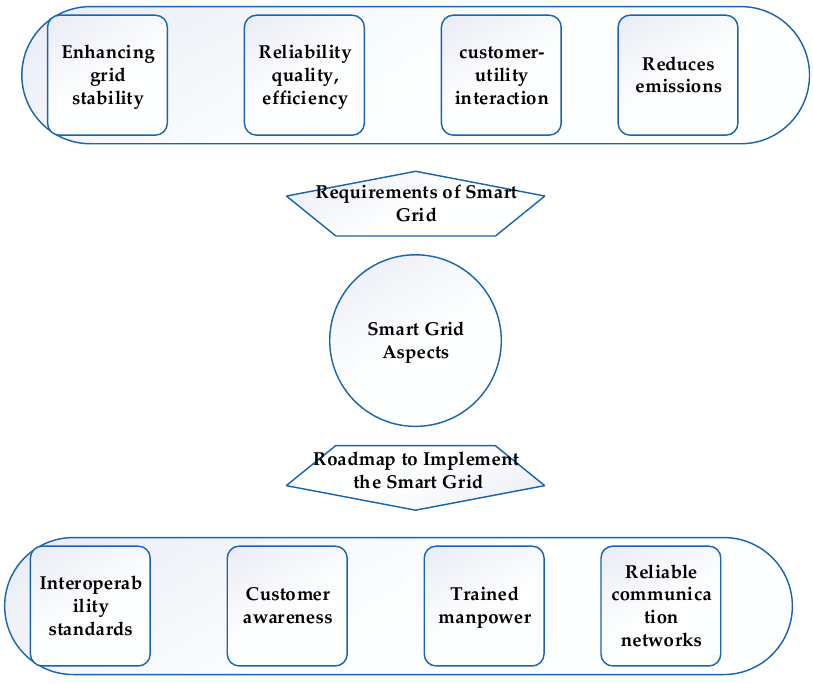
Figure 1. Requirements and roadmap of a smart grid system .